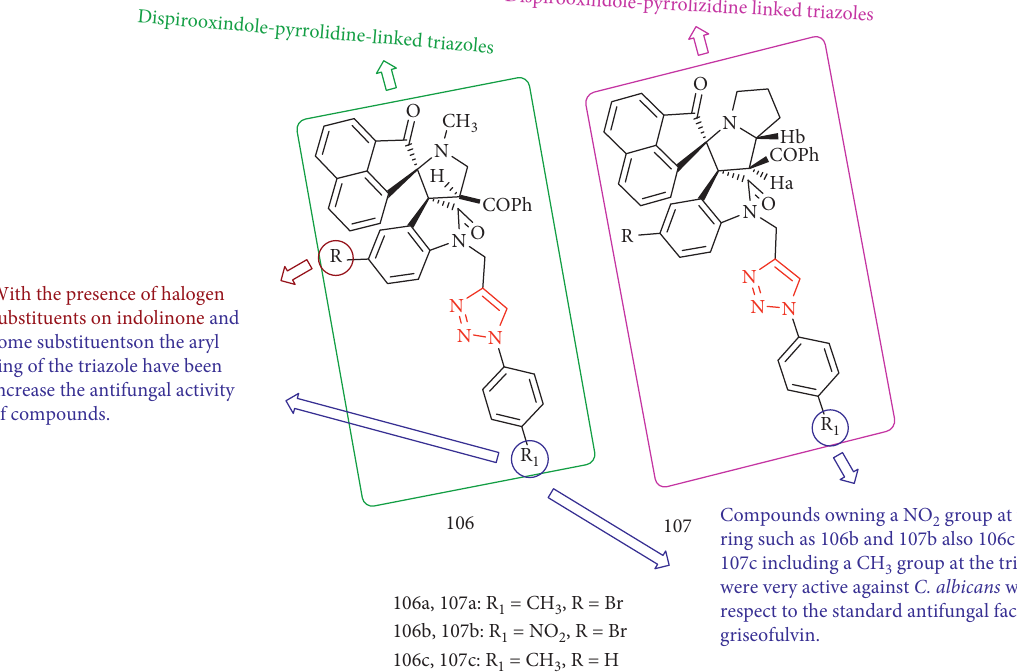
Figure 48: Chemical structure of novel spirooxindole-pyrrolidine/pyrrolizidine-linked 1,2,3-triazole conjugates.